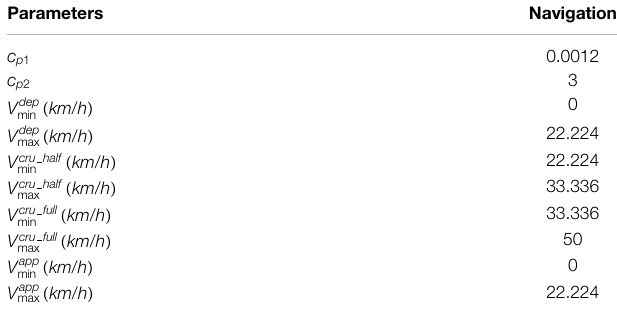
TABLE 3 | Parameters of